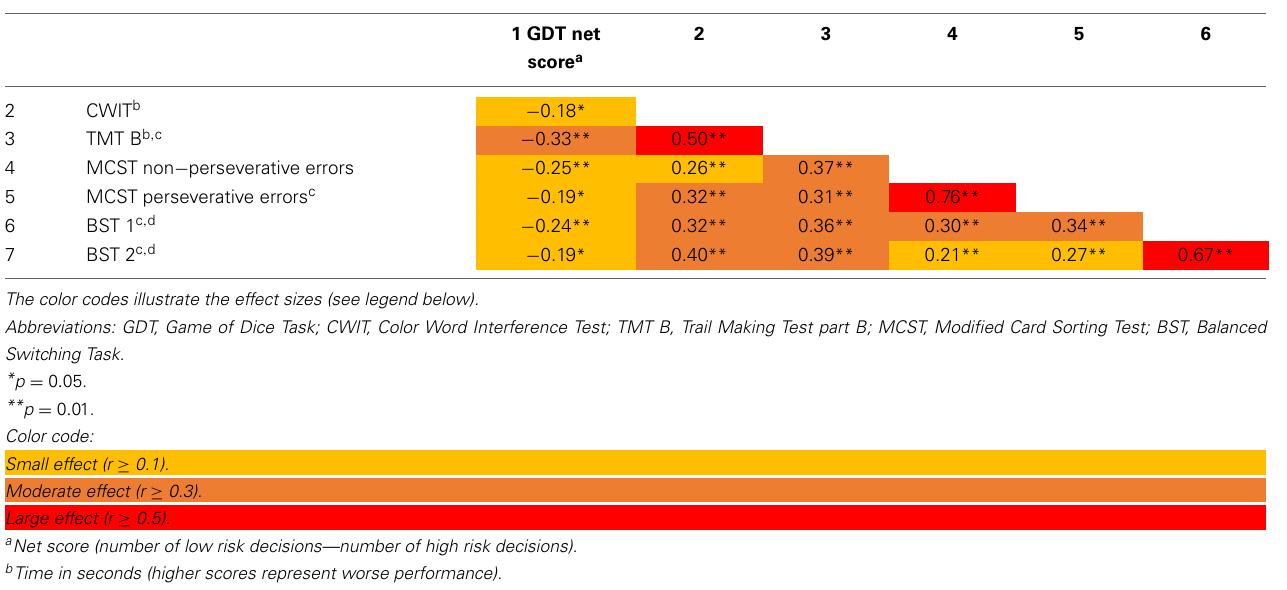
Table 2 | Correlations between GDT net score and tests of executive